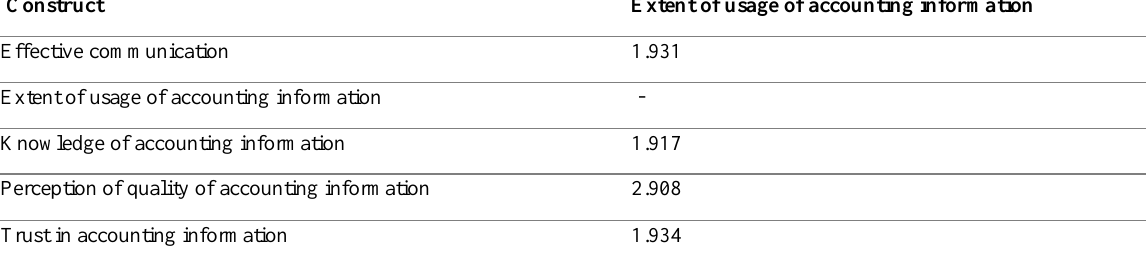
Table 8: VIF Values